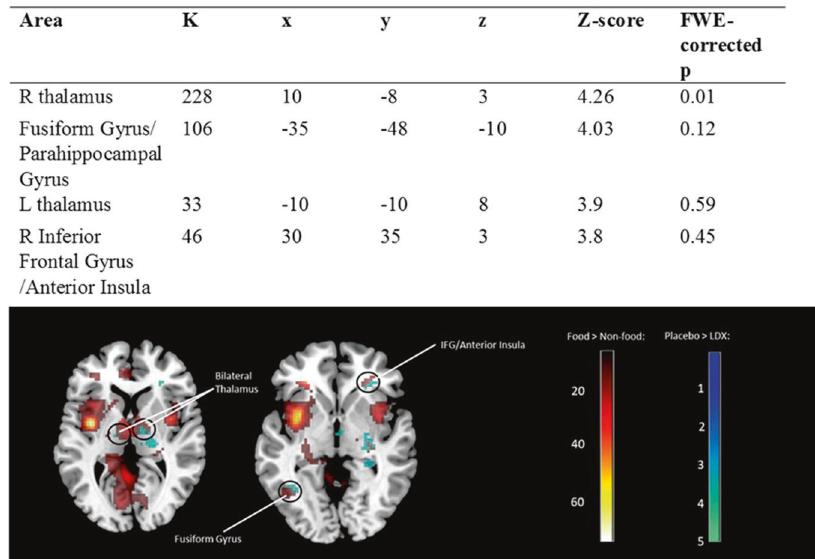
Fig. 4 Clusters signi fi cant for contrast Placebo > LDX at initial uncorrected detection threshold p < 0.001. L = left, R = right (top panel). Regions showing greater responses to food (red) compared to non-food overlaid with regions showing greater responses to food on placebo compared to LDX (blue). Image clusters thresholded at p < 0.001 uncorrected (bottom